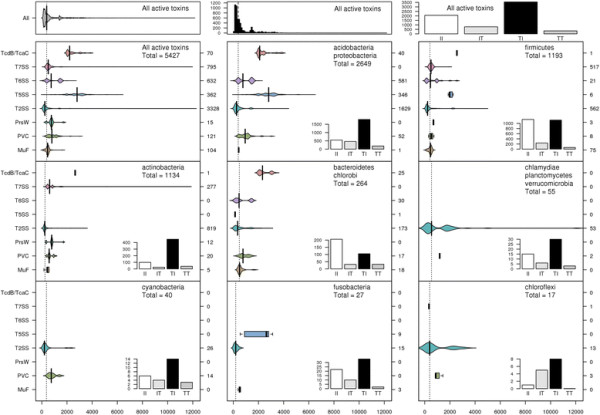
Length distribution for predicted complete active toxins in different bacterial clades. Complete active toxins, as against cassettes, were identified based on characteristic marker domains for each of the distinct secretory systems associated with the toxin either in the same polypeptide or in gene neighborhoods (Table 1). The topmost row shows the combined statistics for all active toxins while other panels present the breakdown of these distributions based on secretory bacterial clades. The toxin length distribution is represented as beanplot[182] (e.g. left panel in the first row) and a raw histogram (top row, central panel) and clearly indicates the multimodal nature of toxin length. The barplot on the first row (rightmost panel) shows the frequencies of consecutive toxin and/or immunity gene pairs in theses genomes. Only pairs of gene encoded by the same strand where considered. The labels indicate whether an immunity protein (I) or a toxin (T) is encoded upstream or downstream of its neighbor in putative operons, e.g. TI corresponds to a pair where an immunity gene is preceded by a toxin gene. Note that the TI (toxin - > immunity) architecture is the most frequent pair observed in all graphs except for bacteroidetes/chlorobi and firmicutes, where the presence of polyimmunity loci inflates the II category. Dashed vertical lines correspond to the median protein length for the data on each panel, and the solid vertical lines over each beanplot correspond to the median length in that secretory system alone. The axes at the right of each panel contain the number of active toxins per secretory system.